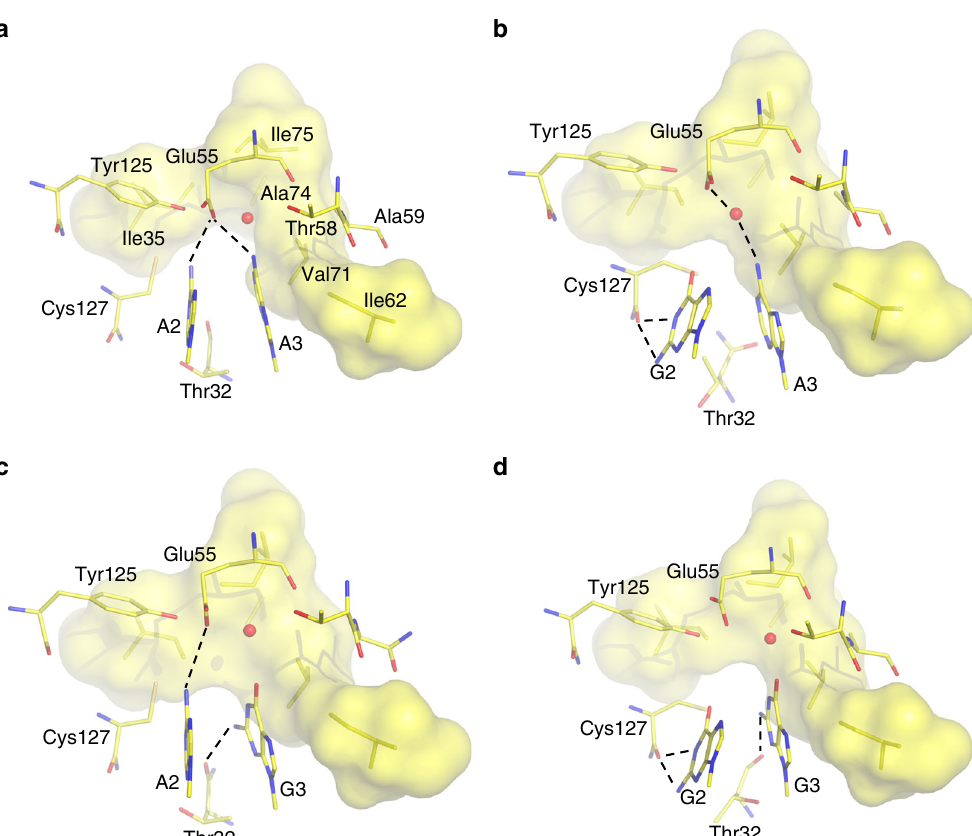
Fig. 4 Structural basis of second and third position stop codon reading. Average MD structures of eRF1 bound to the a UAA, b UGA, c UAG, and d UGG codons. The hydrophobic cluster of residues (Ile35, Ile62, Val71, Ala74, Ile75, and Cys127) is shown as a transparent surface and key water molecules are depicted as red spheres. Key hydrogen bonds involved in base recognition are indicated as dashed